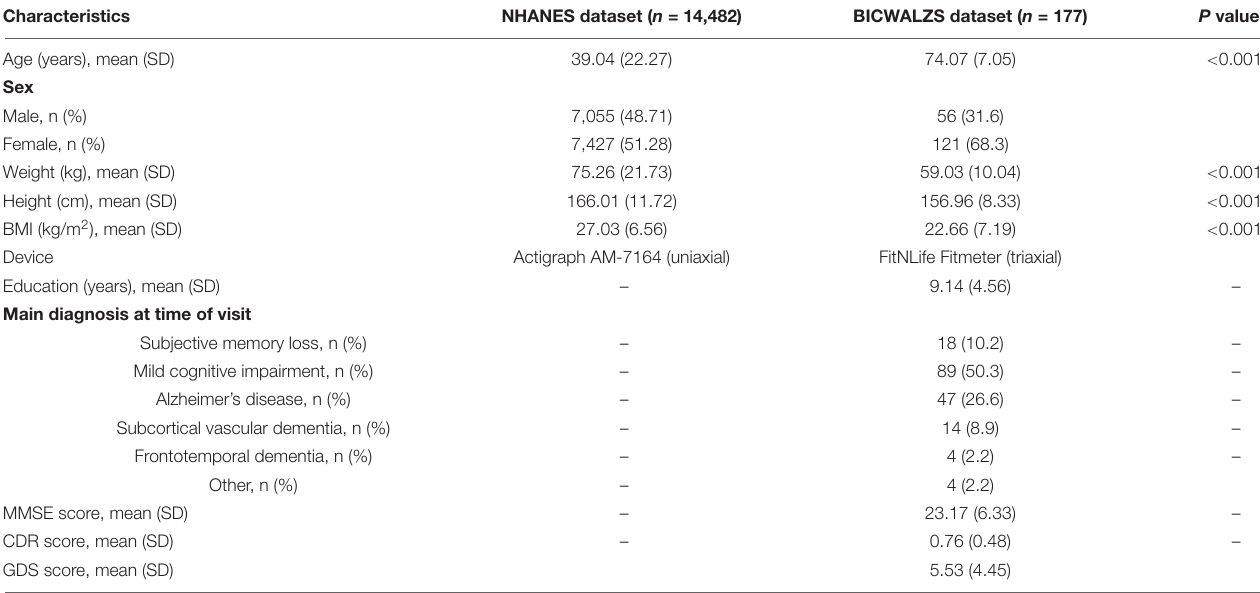
TABLE 1 | Baseline characteristics of the two datasets.